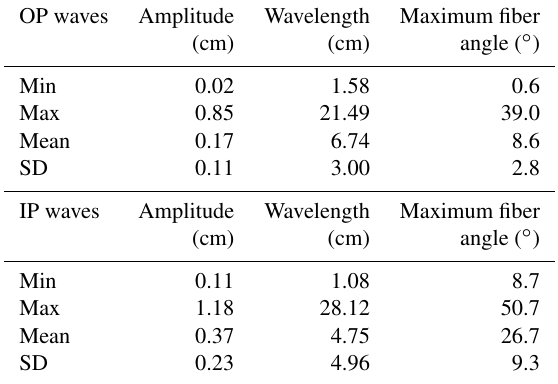
Table 1. Summary of wave data generated from processes outlined in the text.